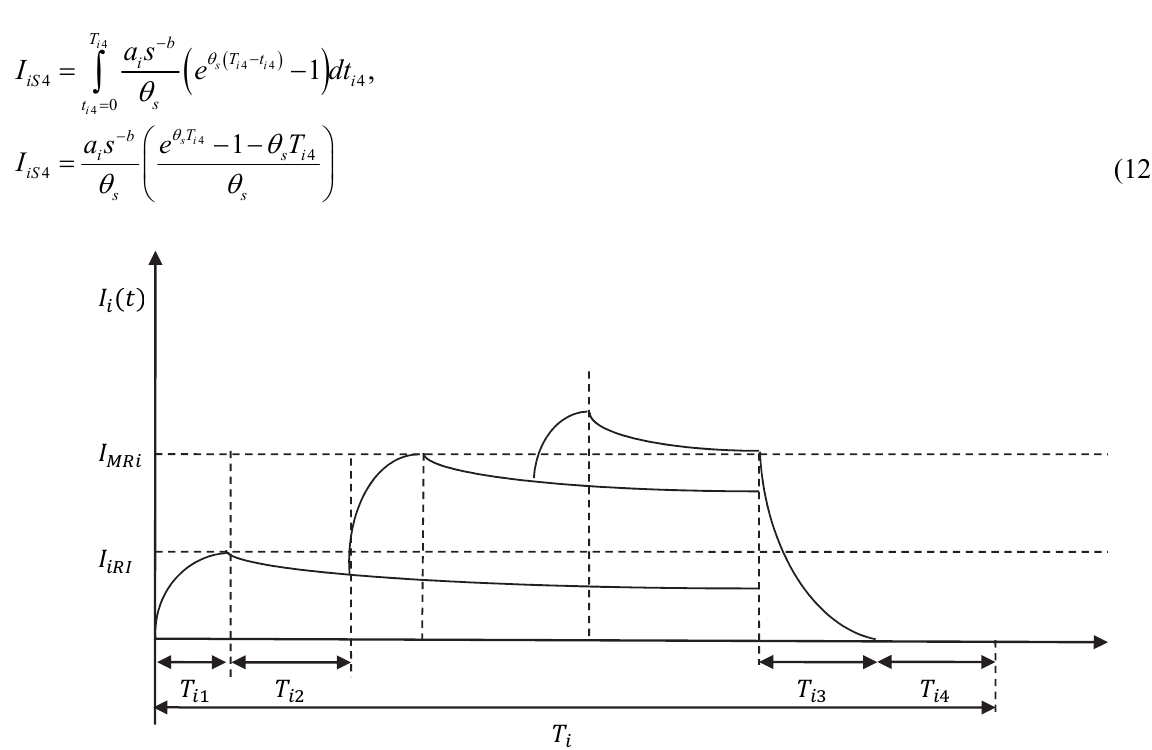
Fig. 3. Recoverable inventory level of 3 production setups and 1 rework